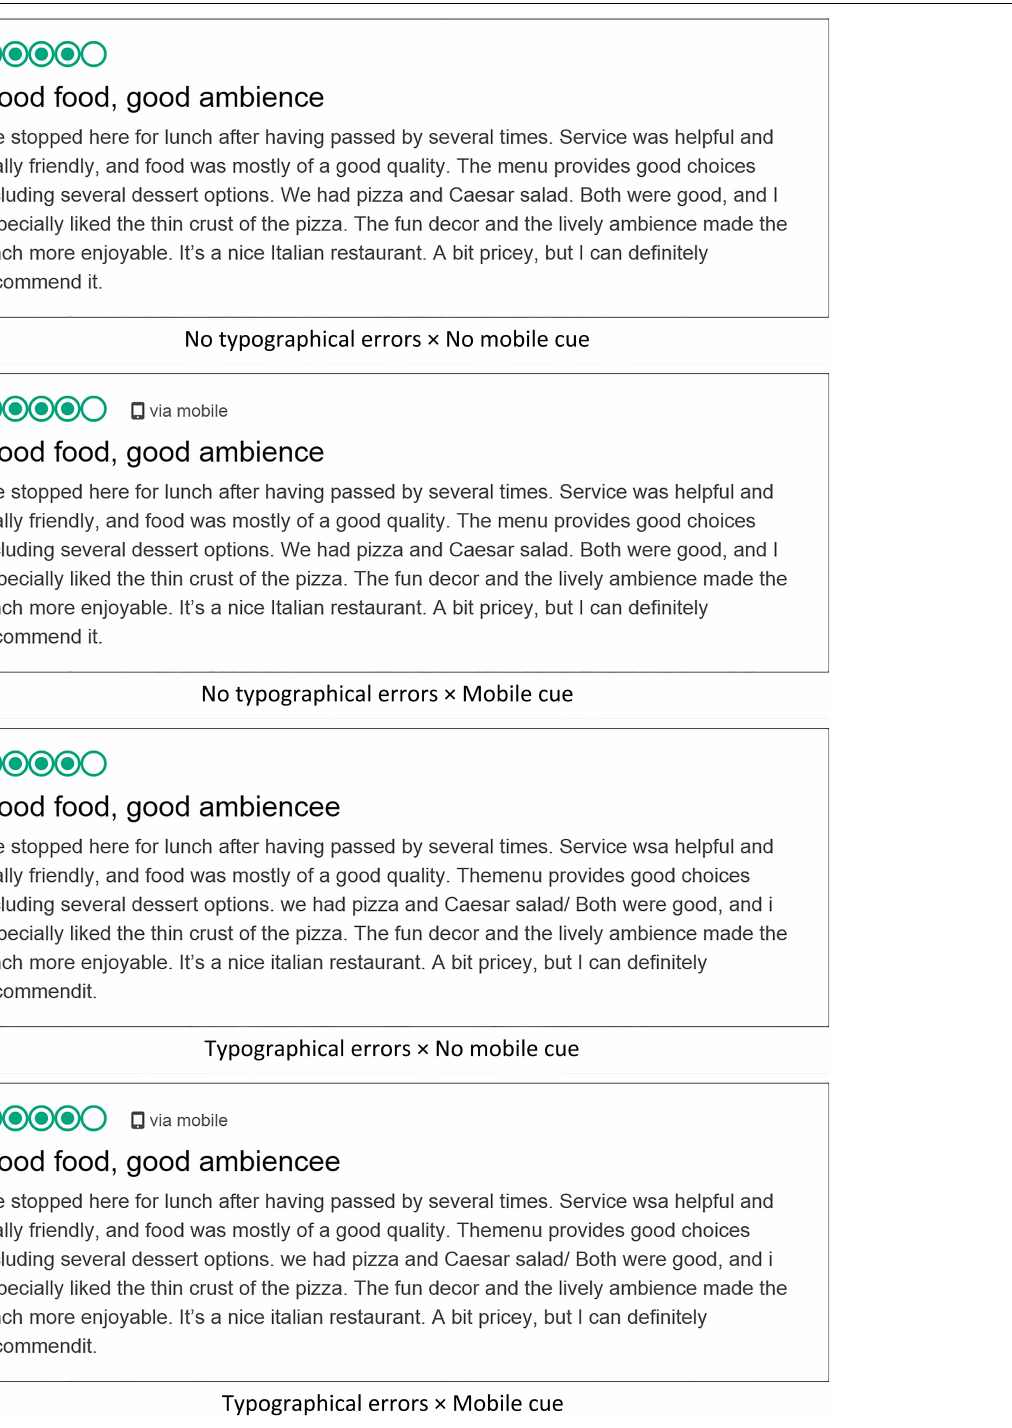
FIGURE 1 | Stimuli.